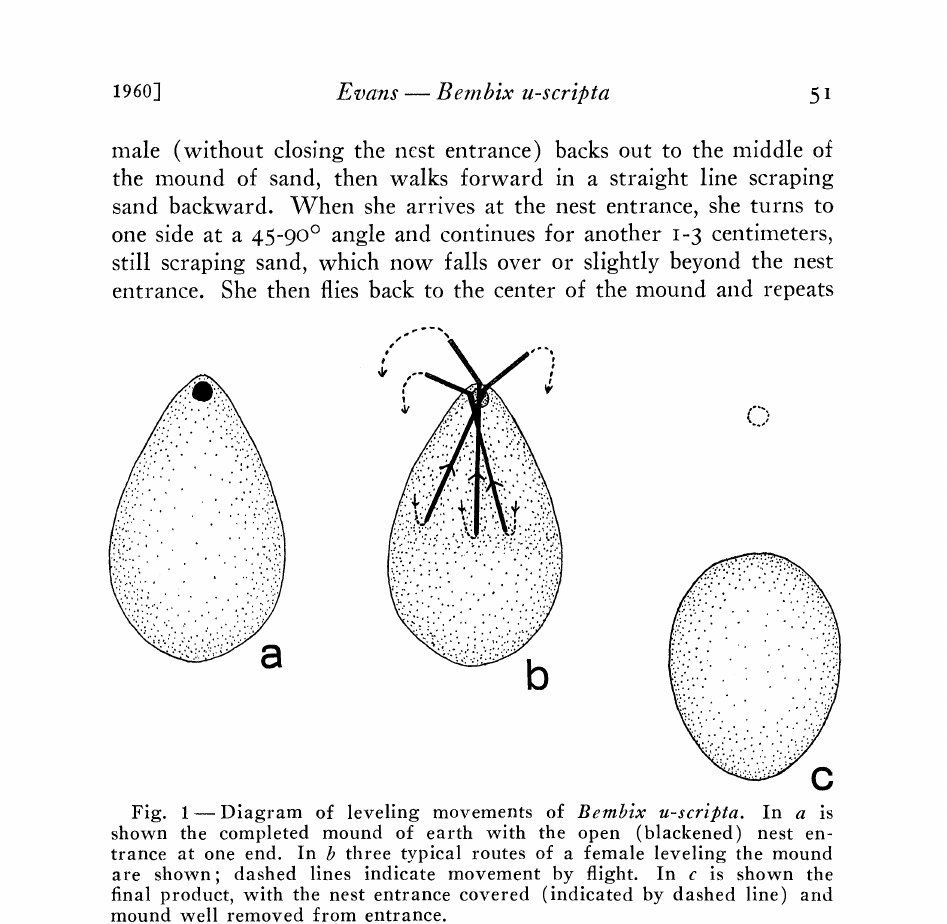
Fig. 1.--Diagram of leveling movements of Bembix u-scripta. In a is shown the completed mound of earth with the open (blackened) nest en- trance at one end. In b three typical routes of a female leveling the mound are shown; dashed lines indicate movement by flight. In c is shown the final product, with the nest entrance covered (indicated by dashed line) and mound well removed from